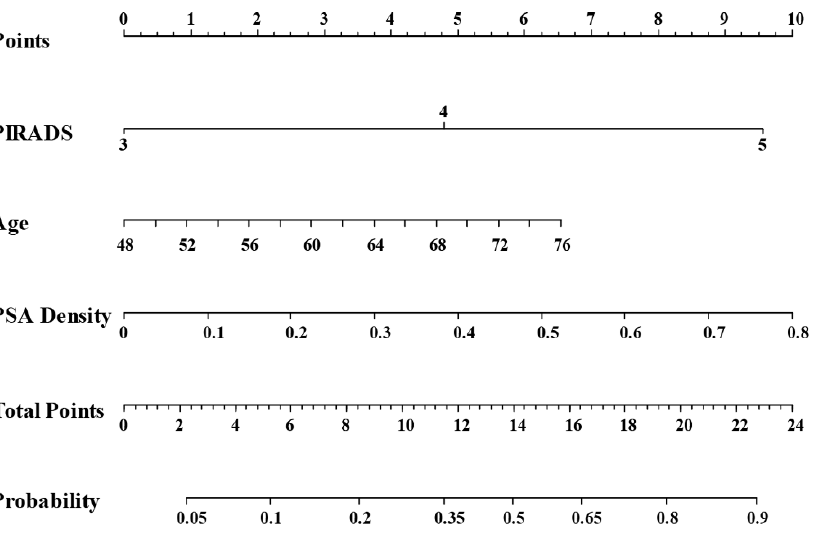
Figure 4. Nomogram with significant clinical variables to predict patients who will benefit from performing systematic random biopsy in addition to TB. The calibration plot demonstrated a good agreement between the model predictions and actual observations for detecting csPCa via SB (Figure 5).